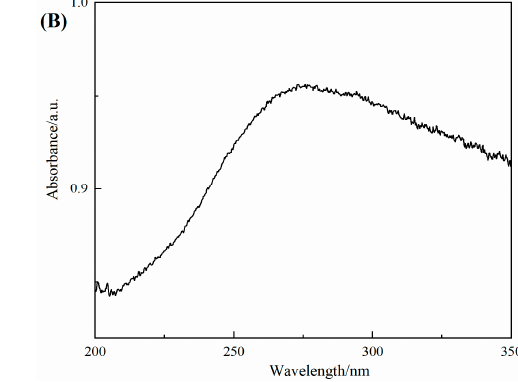
Figure 2. UV spectra of ( A ) GO and ( B ) 3D–rGO.